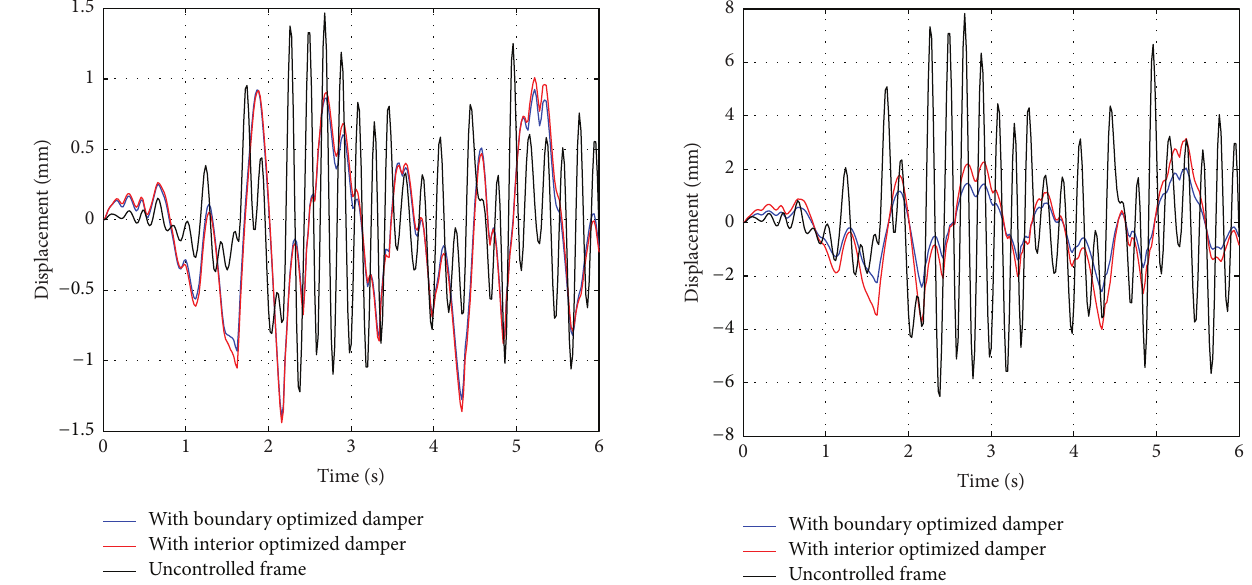
Figure 33: Time-history curve under large